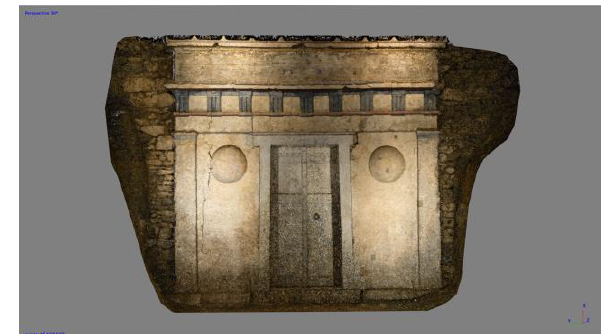
Figure 6. The Tomb of Philip II in Verghina. Cloud of points